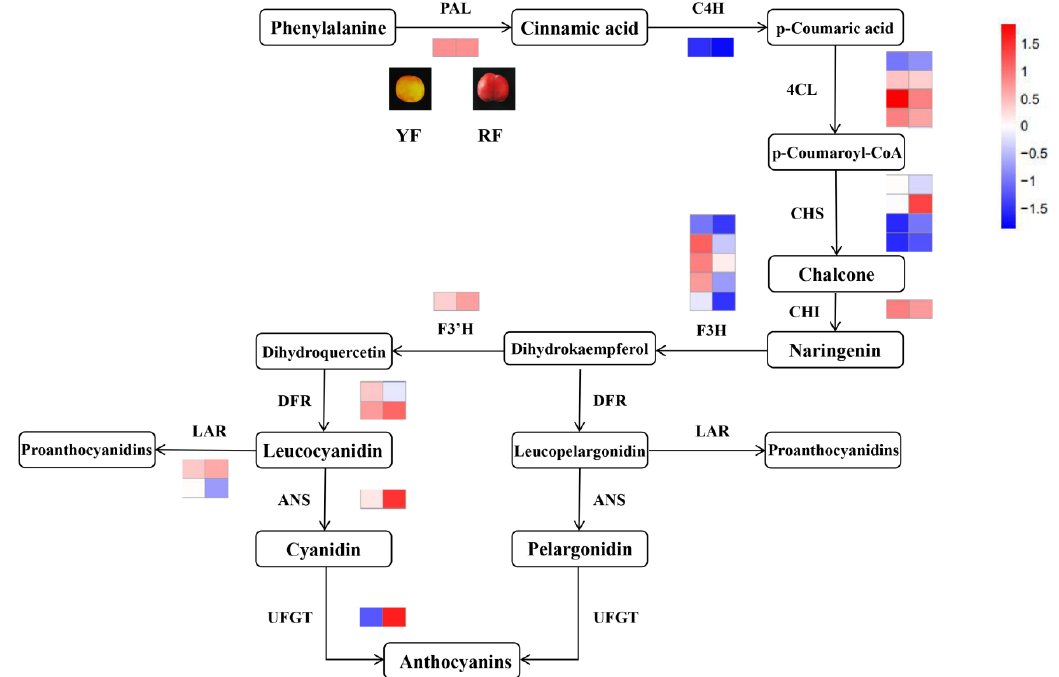
Figure 8. Cerasus humilis fruit peel unigenes thought to be included in the anthocyanin biosynthetic pathway, and their gene expression levels. The heatmap was created according to the average expression levels of related biosynthetic genes based on the RPKM values. A color bar is presented at the top right. Blue indicates low expression, and red indicates high expression. Abbreviations are as follows: